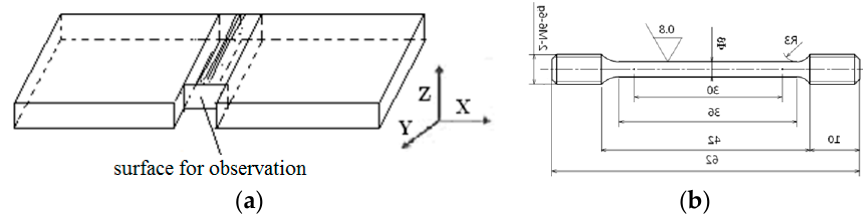
Figure 3. ( a ) Schematic diagram of the intercepting process for the metallographic specimen; ( b ) Tensile specimen dimensions.